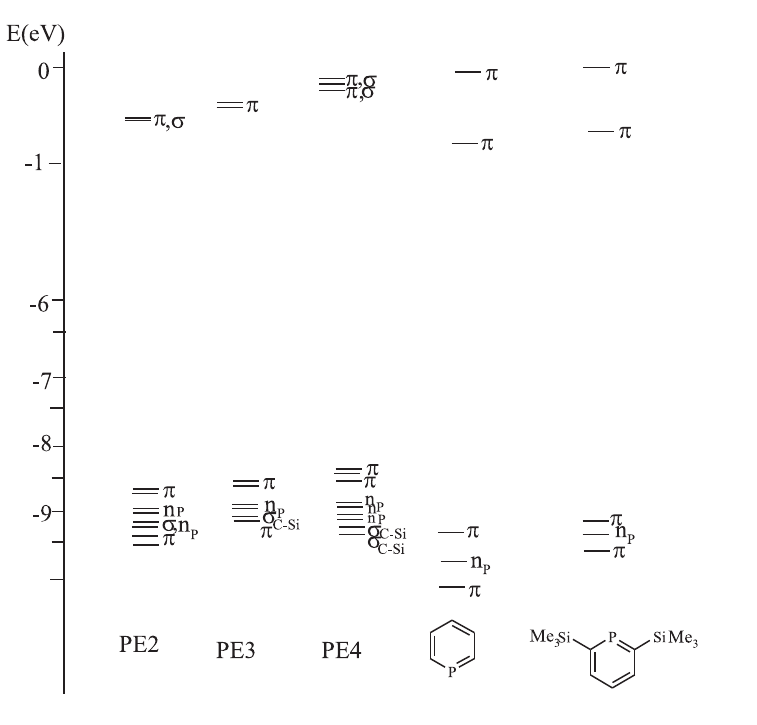
Fig. 3 Electronic levels of phosphinine-ether macrocyles computed with PM3 method [41]. PE2 PE3 PE4